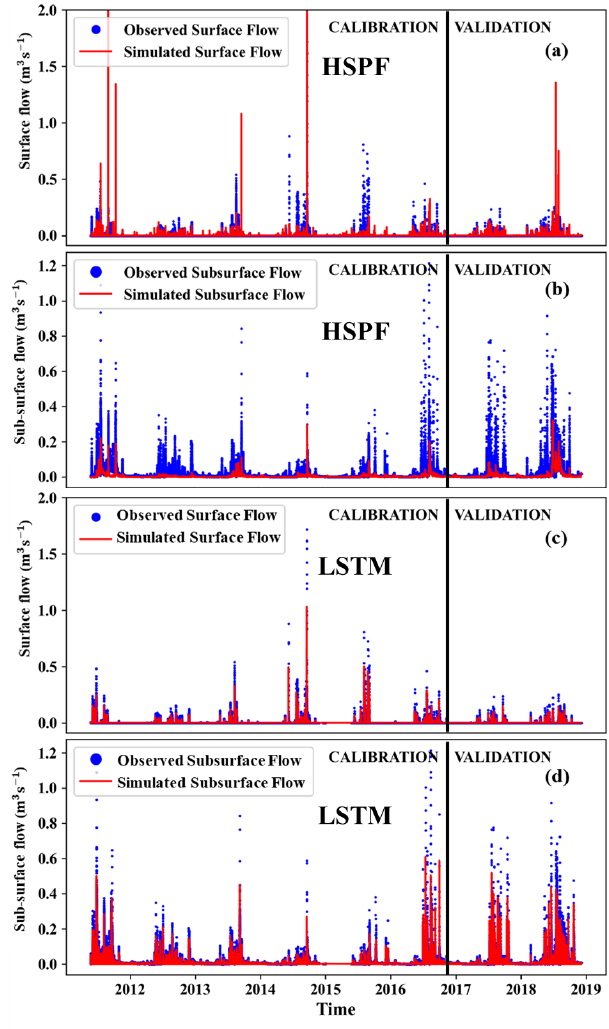
Figure 4. Hydrological simulation from HSPF and LSTM: (a) sim- ulated and observed surface flow from HSPF, (b) simulated and ob- served subsurface flow from HSPF, (c) simulated and observed sur- face flow from LSTM, and (d) simulated and observed subsurface flow from